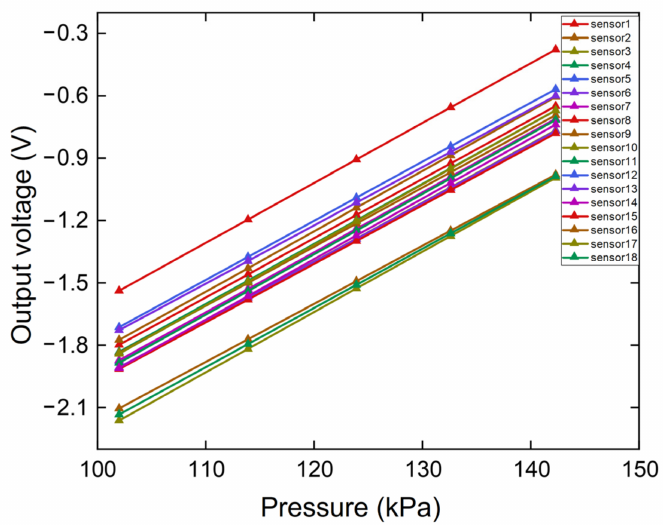
Figure 4. Sensor array output voltage and linear fitting